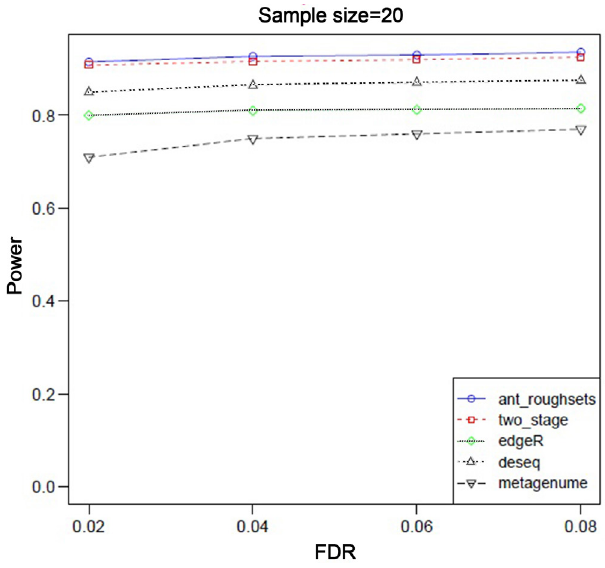
Fig. 13. The power in detection of the true differentially abundant genes for the five methods at various levels of FDR for sample size of